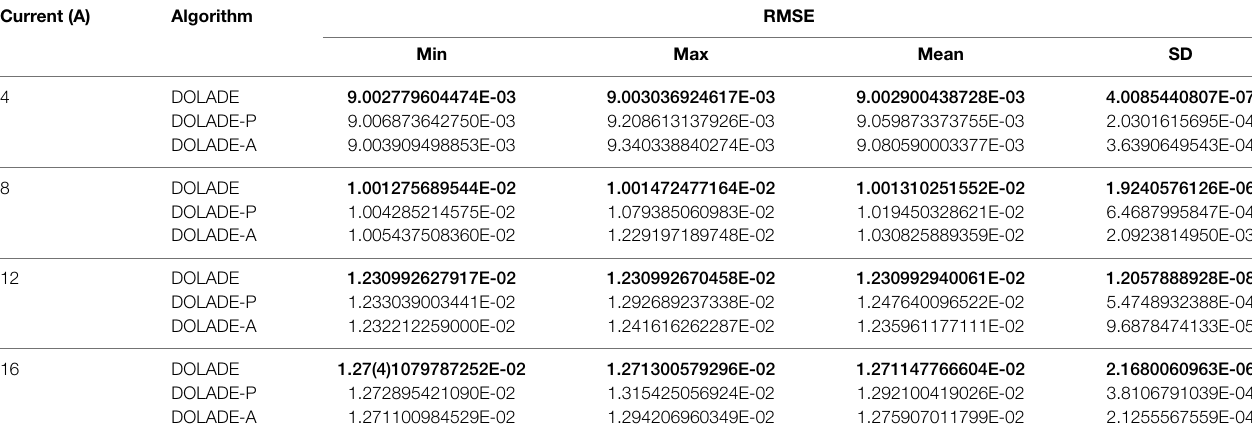
TABLE 6 | Statistical results of RMSE for different sets under different